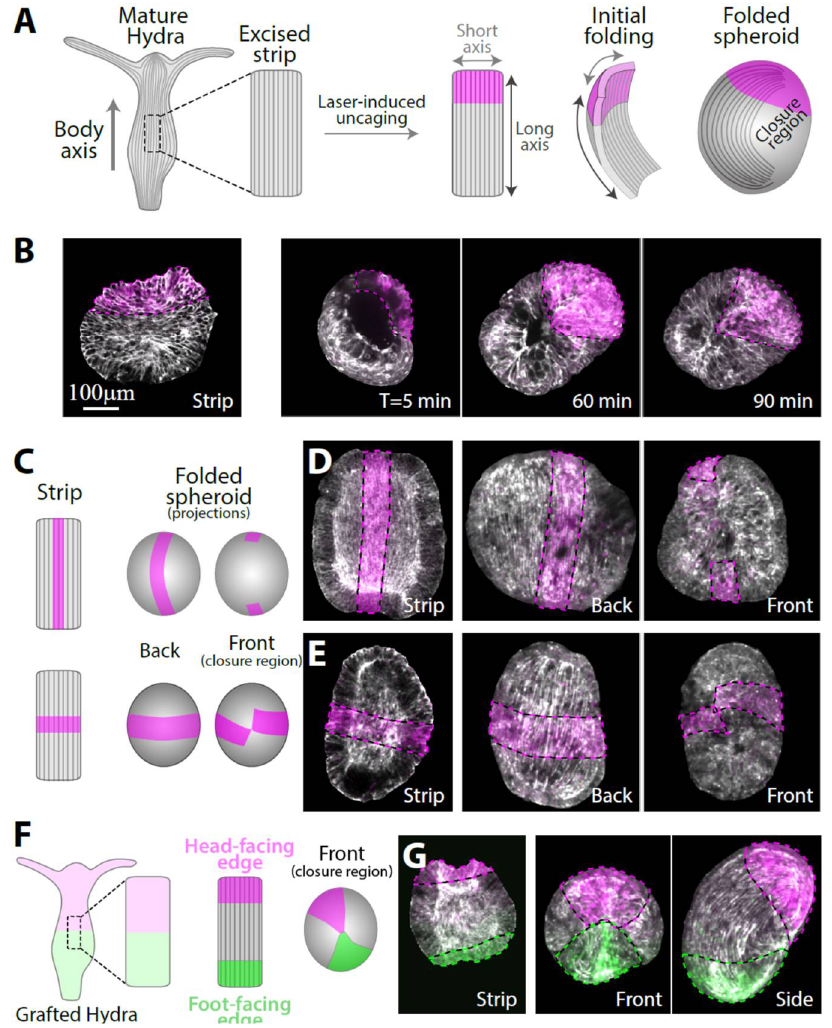
Figure 1 . The folding of an excised tissue strip into a hollow spheroid. ( A ) Schematics showing a tissue strip excised from a mature Hydra and fluorescently labeled at its head-facing side. The rectangular strip initially curls along both of its primary axes and subsequently closes into a sealed hollow spheroid. The supracellular ectodermal actin fibers that are aligned with the body axis of the parent animal are shown. ( B ) Left: Scanning confocal image of an excised strip after laser-induced uncaging of Abberior CAGE 552 at its head-facing side (see Methods). Right: Spinning disk confocal images from time-lapse movies of excised strips labeled at their head-facing side. The tissue curls along its two major axes and seals with opposite ends of the strip adhering to each other. ( C ) Schematics and ( D–E ) images of excised tissue strips that are labeled along a central line parallel to the body axis of the parent animal ( C , top; D ) or along a medial line perpendicular to the body axis of the parent animal ( C , bottom; E ). Left: scanning confocal images of the labeling pattern in flattened excised tissue strips. Right: spinning disk confocal projected images of the folded spheroids ~3 hours after excision from two different viewpoints showing the closure region (front) and the opposite side (back). ( F ) Schematics and ( G ) images of an excised tissue strip labeled with two different colors at its sides. The strip is excised from a grafted animal containing Abberior CAGE 552 at its upper half and Abberior CAGE 635 at its lower half and differentially labeled at both ends by laser-induced uncaging. The originally head-facing edge of the strip (magenta) adheres to the originally foot-facing edge (green). All images show an overlay of lifeact-GFP (gray), with uncaged Abberior CAGE 552 (magenta), and, in ( G ), also with uncaged Abberior CAGE 635 (green).